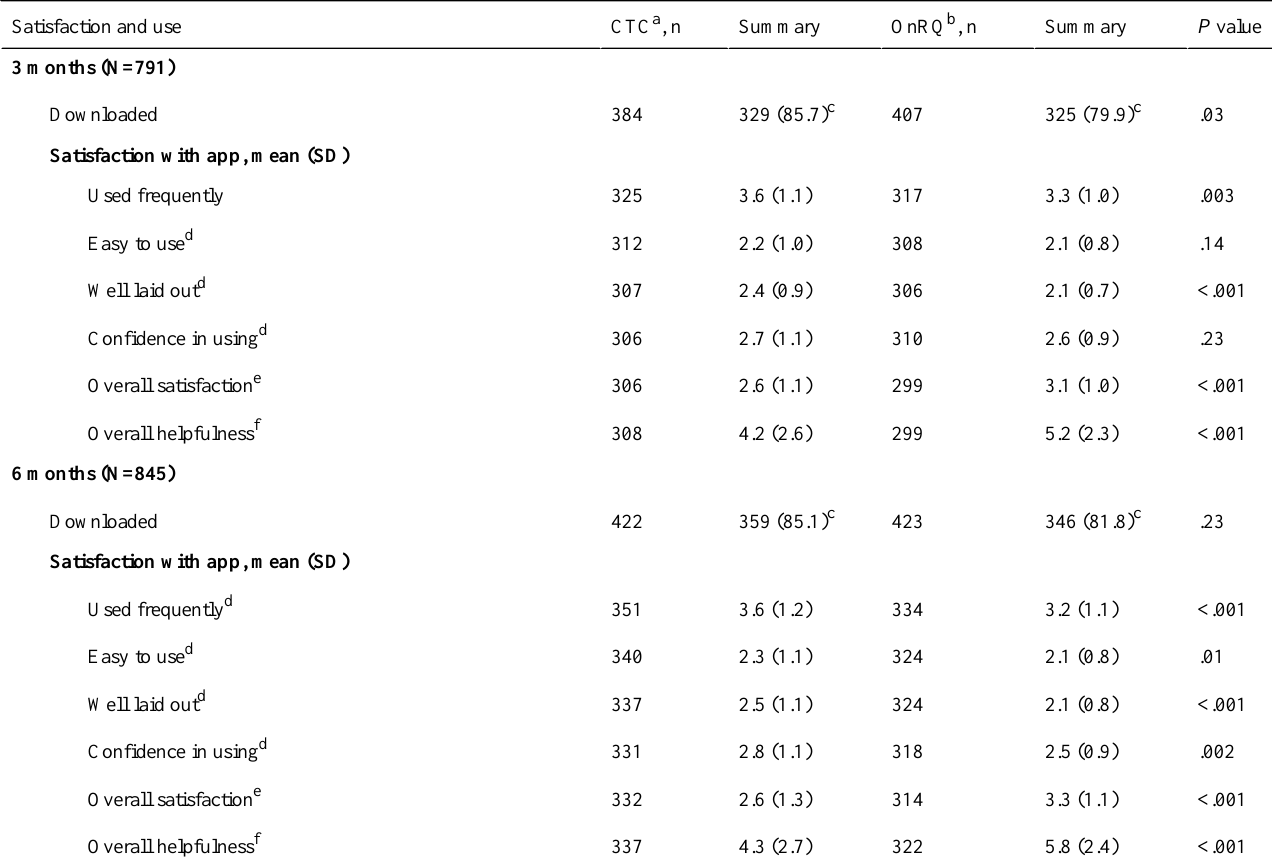
P valueSummaryOnRQ b , nSummaryCTC a , nSatisfaction and use